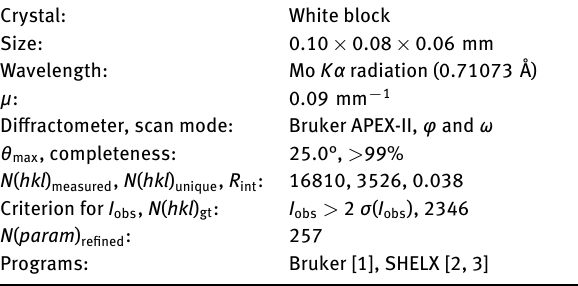
Table 2: Fractional atomic coordinates and isotropic or